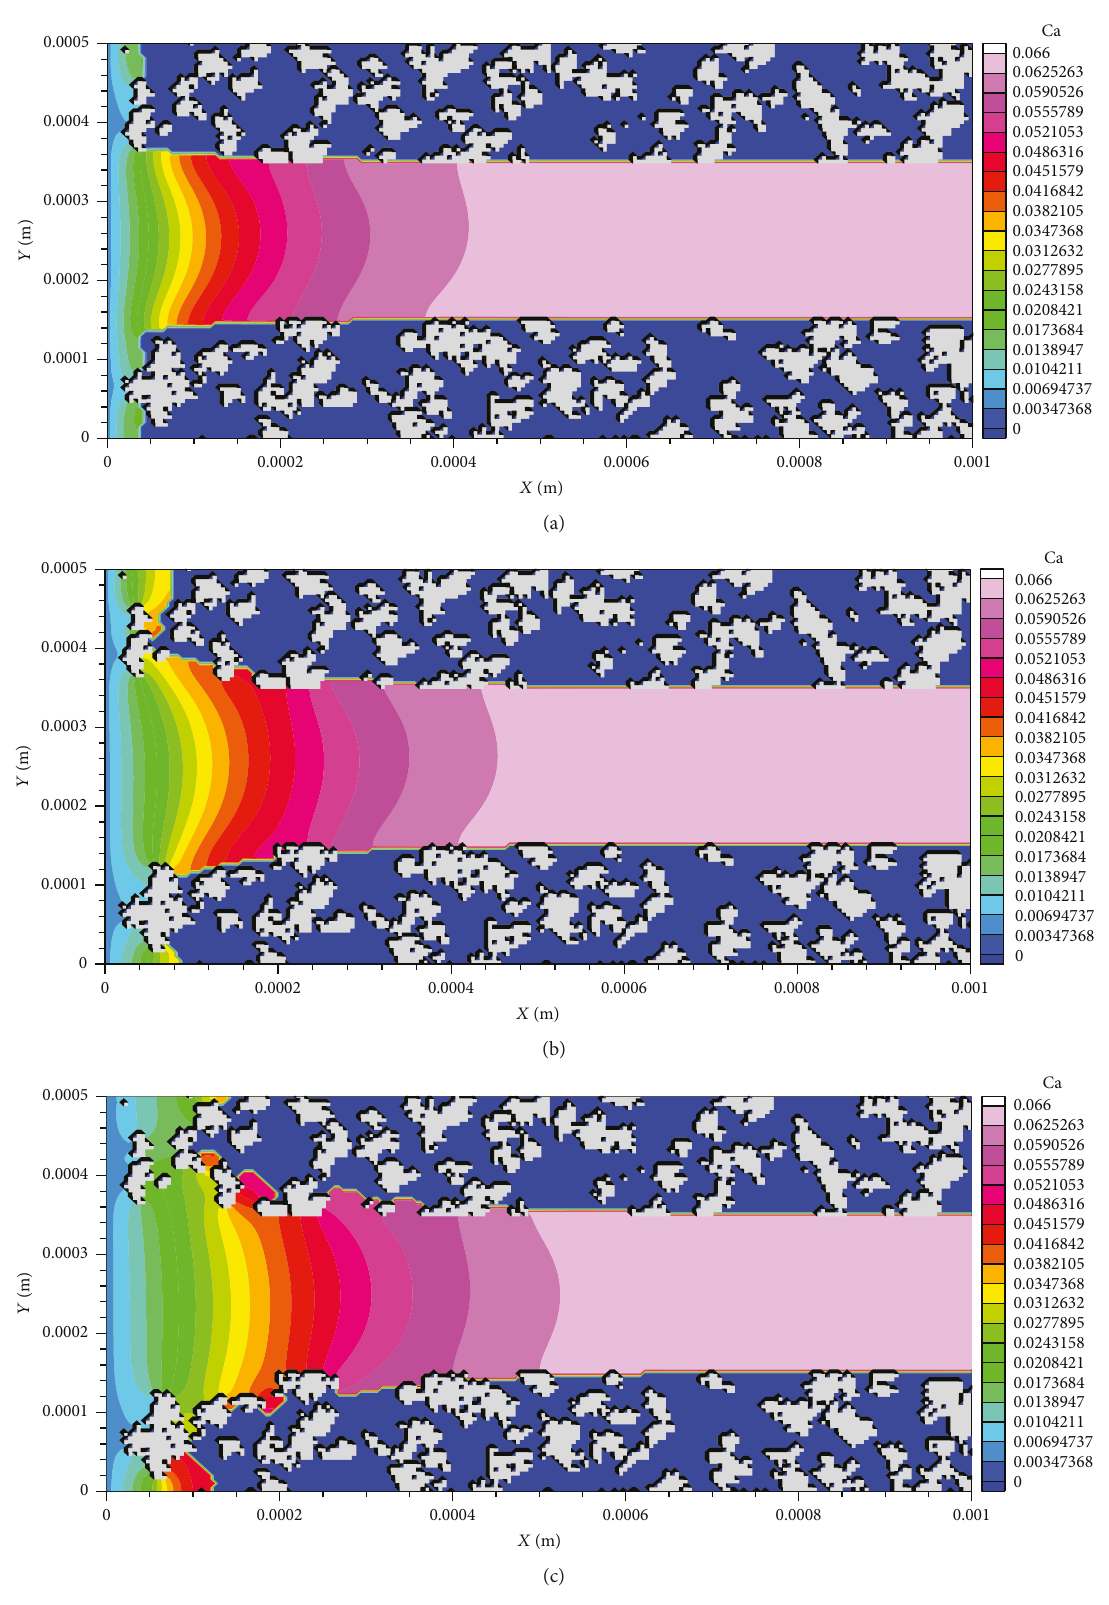
Figure 15: Ca concentrations (mol/L) at (a) t = 6 2 hr, (b) t = 20 5 hr, and (c) t = 42 hr. In all three cases, Pe =0.026 and kaolinite is illustrated in light